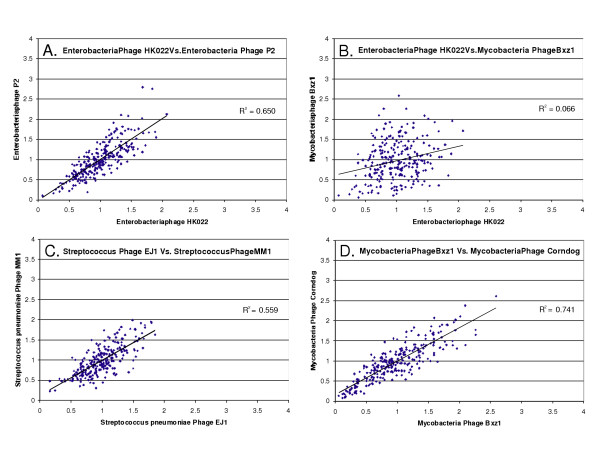
Linear regression analysis of DNA tetranucleotide usage profiles among selected genomes. Each of the 256 tetranucleotide combinations were determined for each genome as described in Materials and Methods, and the profiles compared by linear regression analysis. Panels A: Enterobacteria phage HK022 (Siphoviridae) vs. P2 (Myoviridae). Panel B: Enterobacteria phage HK022 vs. Mycobacterium phage Bxz1 (Myoviridae). Panel C: Streptococcus pneumoniae phage EJ1 (Myoviridae) vs. MM1 (Siphoviridae). Panel D: Mycobacterium phage Bxz1 vs. Corndog (Siphoviridae).